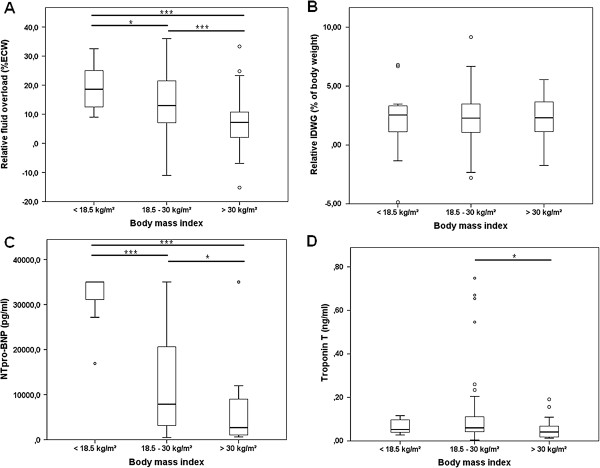
Patient groups were compared according to BMI (<18.5 kg/m2, n = 14; 18.5-29.9 kg/m2, n = 173; ≥30 kg/m2, n = 56). (A) Student’s t-Test for (A) relative fluid overload and (B) relative interdialytic weight gain. Kruskal-Wallis test was used for (C) NT-proBNP and (D) troponin T.